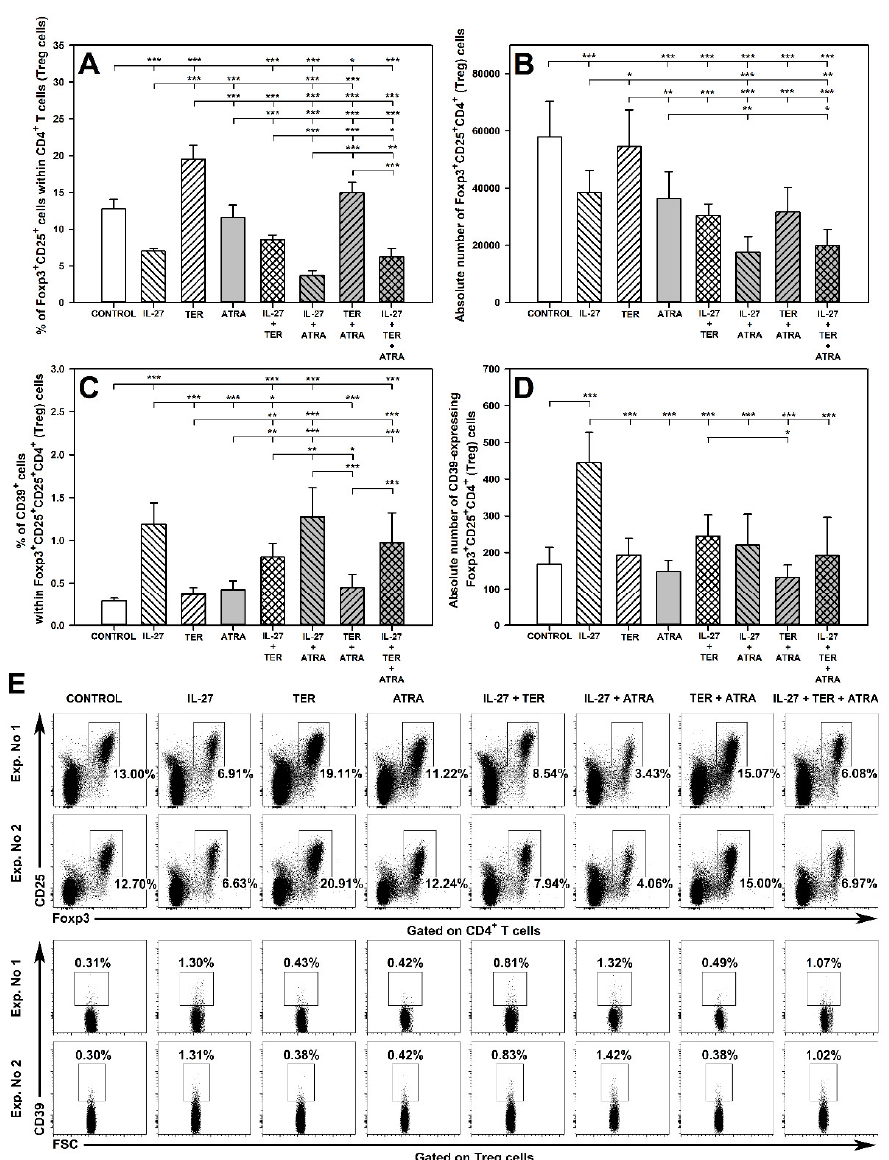
Figure 5. Effect of IL-27, teriflunomide (TER), all-trans-retinoic acid (ATRA), and their combinations on the number of Foxp3 + CD25 + CD4 + regulatory T (Treg) cells and their CD39-expressing cell subsets under unstimulated conditions. The relative ( A , C ) and absolute count ( B , D ) of these cells were determined in cell cultures incubated in the absence (CONTROL) and presence of IL-27 (100 ng/mL), TER (10 −4 M), and ATRA (10 −6 M) for 96 h. The relative count is expressed as a percentage of Foxp3 + CD25 + cells within CD4 + T cell subset ( A ) and CD39 + cells within Foxp3 + CD25 + CD4 + ( C ) T cell subset. The absolute count represents the number of Foxp3 + CD25 + CD4 + ( B ) and CD39 + Foxp3 + CD25 + CD4 + T cells ( D ) per sample well. Results are expressed as the mean ( ± S.D.) of two independent experiments with four mice per experiment (overall n = 8, * p < 0.05, ** p < 0.01, *** p < 0.001). Examples of dot plot cytograms for all treatments show the distribution of Foxp3 + CD25 + ( E , upper panel) and CD39 + ( E , lower panel) cells within CD4 + and Foxp3 + CD25 + CD4 + T cell subsets,